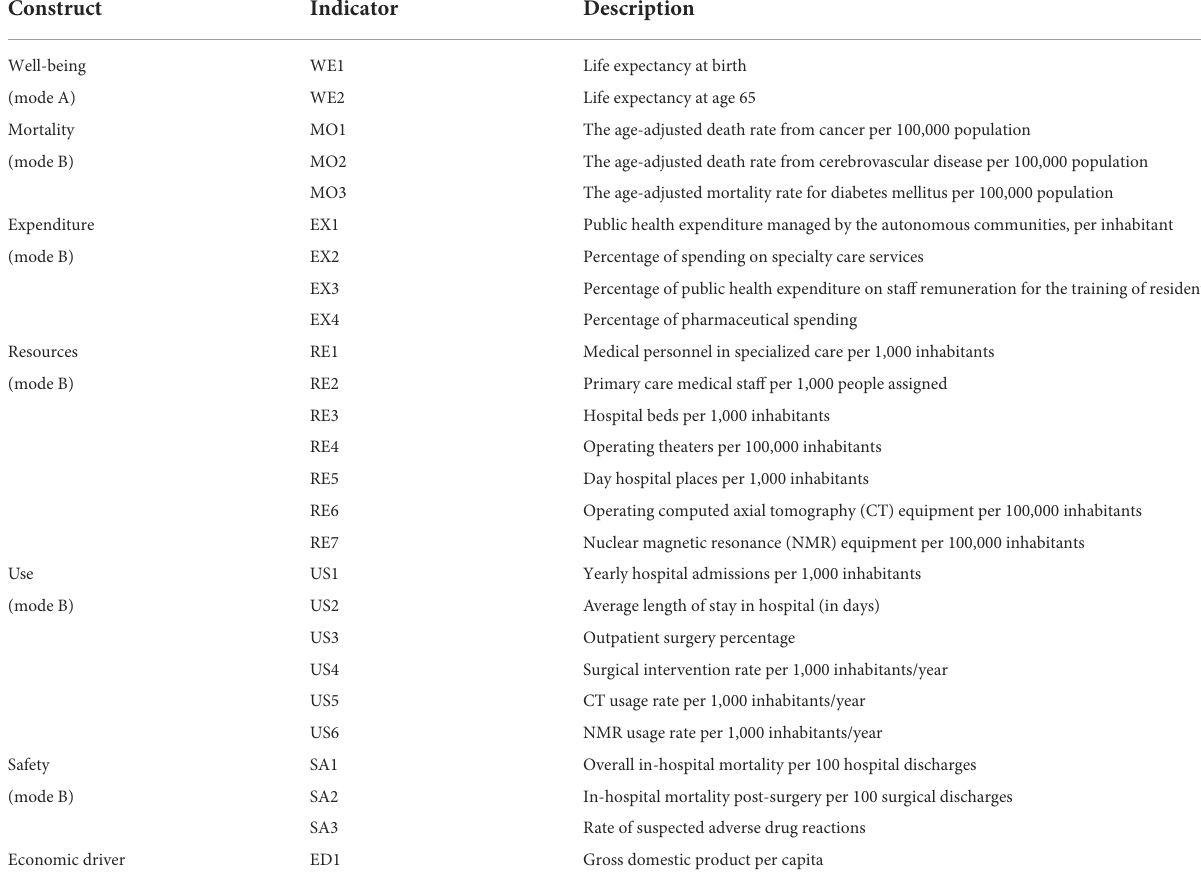
TABLE 1 Constructs and description of